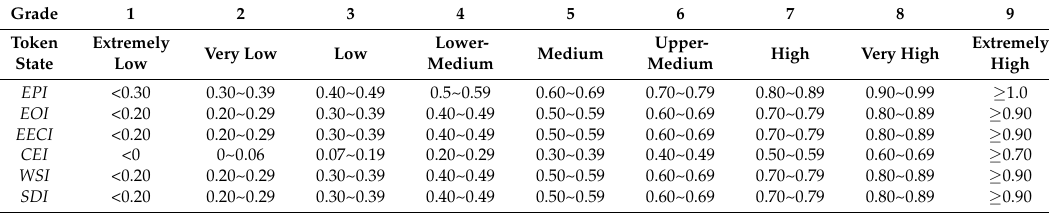
Table 1. The grading criteria for each indicator in the sustainable development evaluation system.